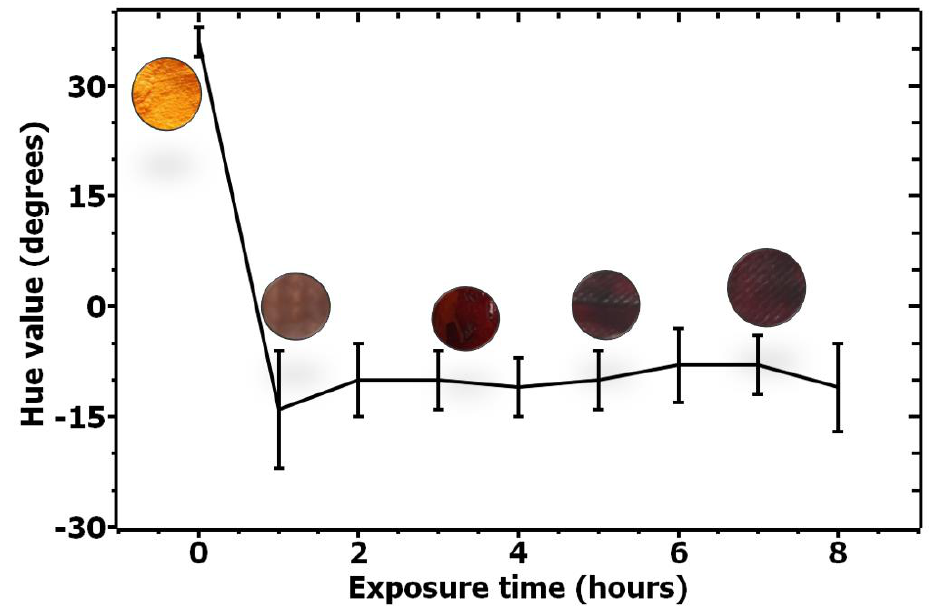
Figure 3. Quantification of color change for ethanal-sensitive solution upon exposure to ethanal from 0 to 8 h.